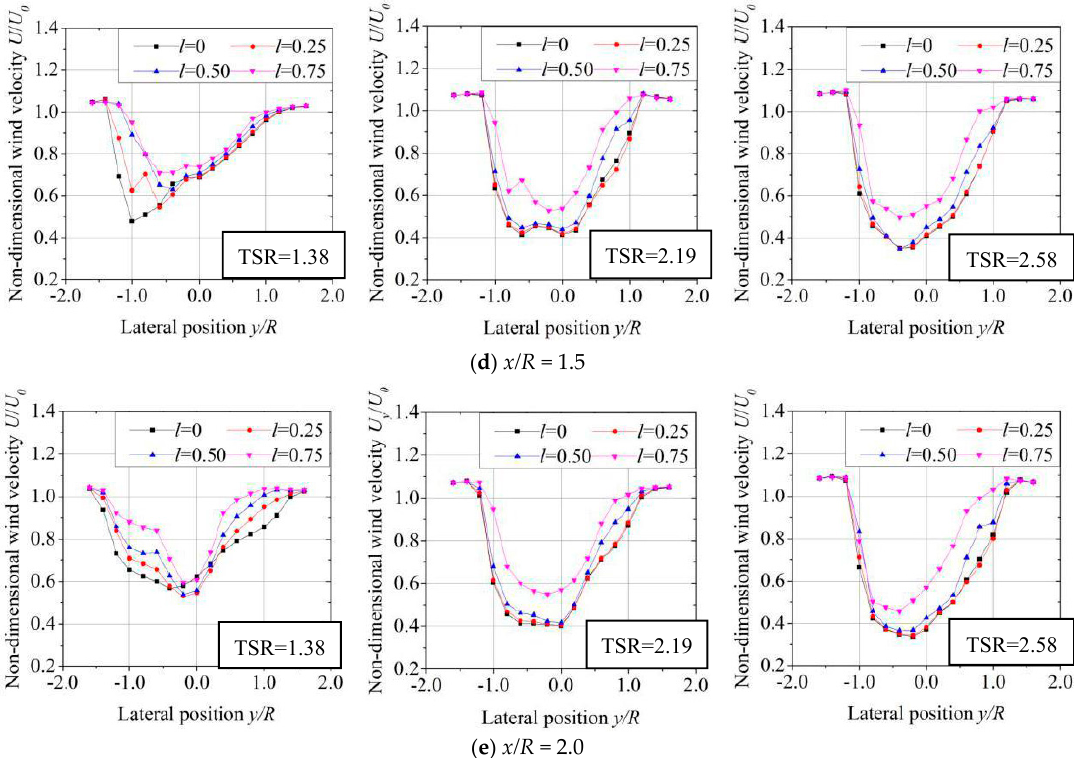
Figure 11. Fluctuation of wind velocity for the spanwise cross-sections of l = 0, 0.25, 0.50 and 0.75 in downstream region ( x/R = 0, 0.5, 1.0, 1.5 and 2.0) at the three different TSRs with the azimuth angle of θ =90°: ( a – e ) show the fluctuations of wind velocity of x/R = 0, 0.5 1.0, 1.5 and 2.0, respectively.